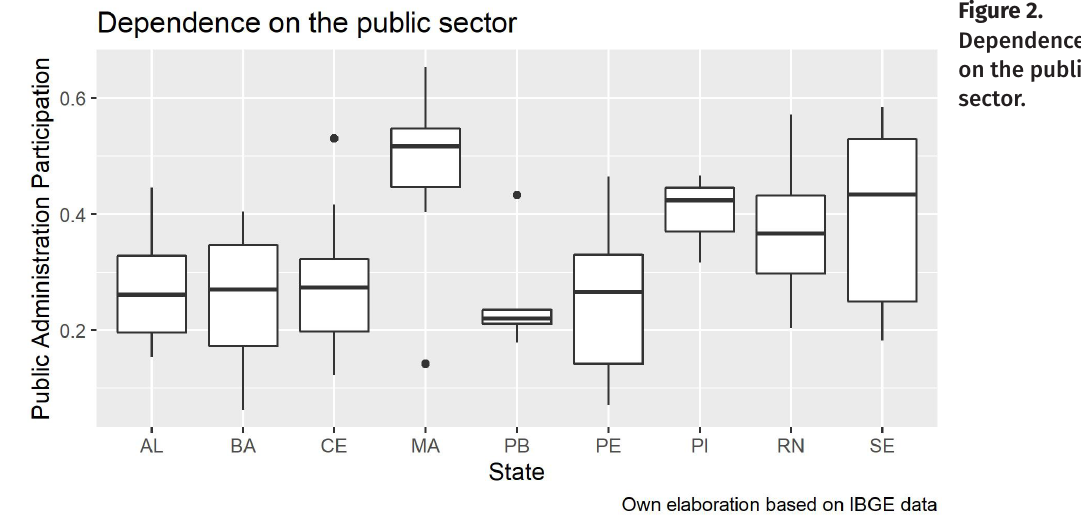
Figure 2. Dependence on the public